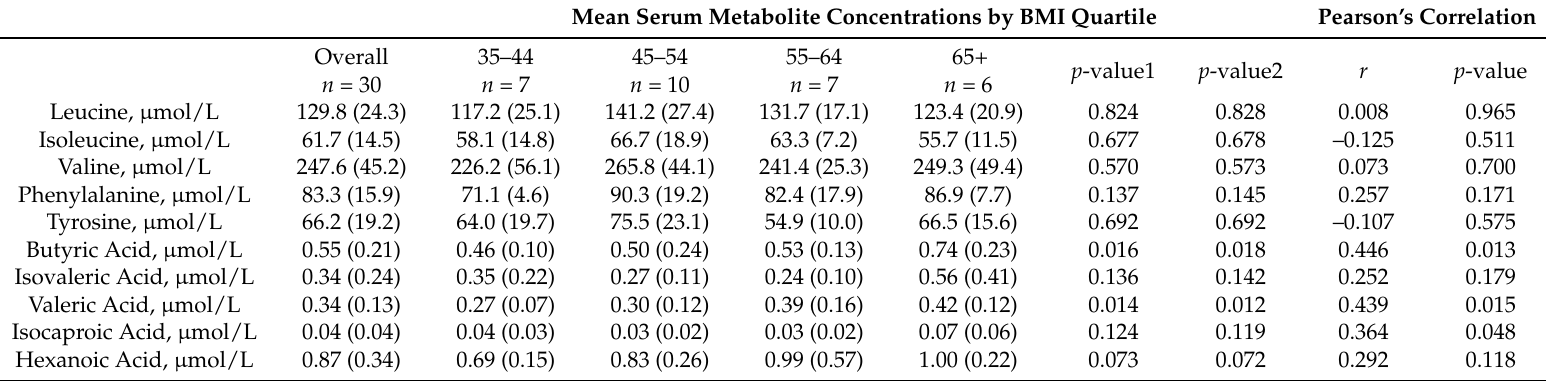
Table 4. Association between preoperative concentrations of branched chain amino acids, aromatic amino acids, and short-chain fatty acids and BMI *. Mean Serum Metabolite Concentrations by BMI Quartile Pearson’s